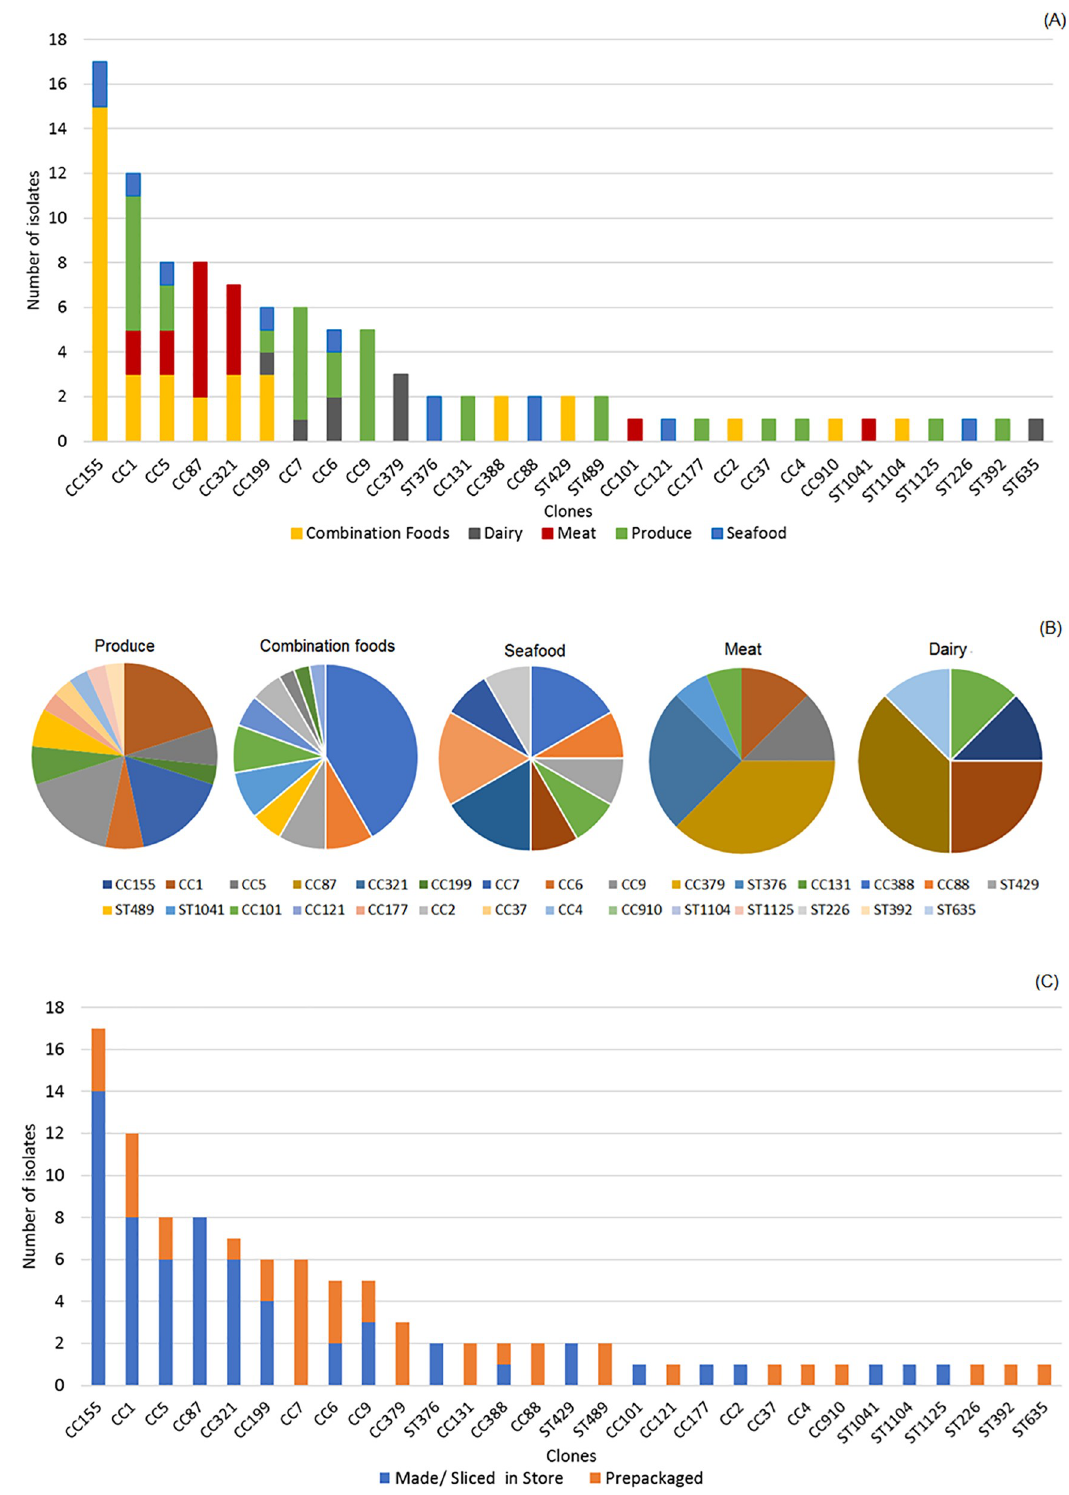
Fig 3. Diversity in clonal complex (CC) and sequence type (ST) of L . monocytogenes isolates from the 2010–2013 Lm MBS survey, by (A) and (B) food group, and (C) manufacturing location of food samples in which isolates were obtained. Fig 3A illustrates the number of isolates in each food group in each clone. Fig 3B illustrates the percentage of each clone in each food group.